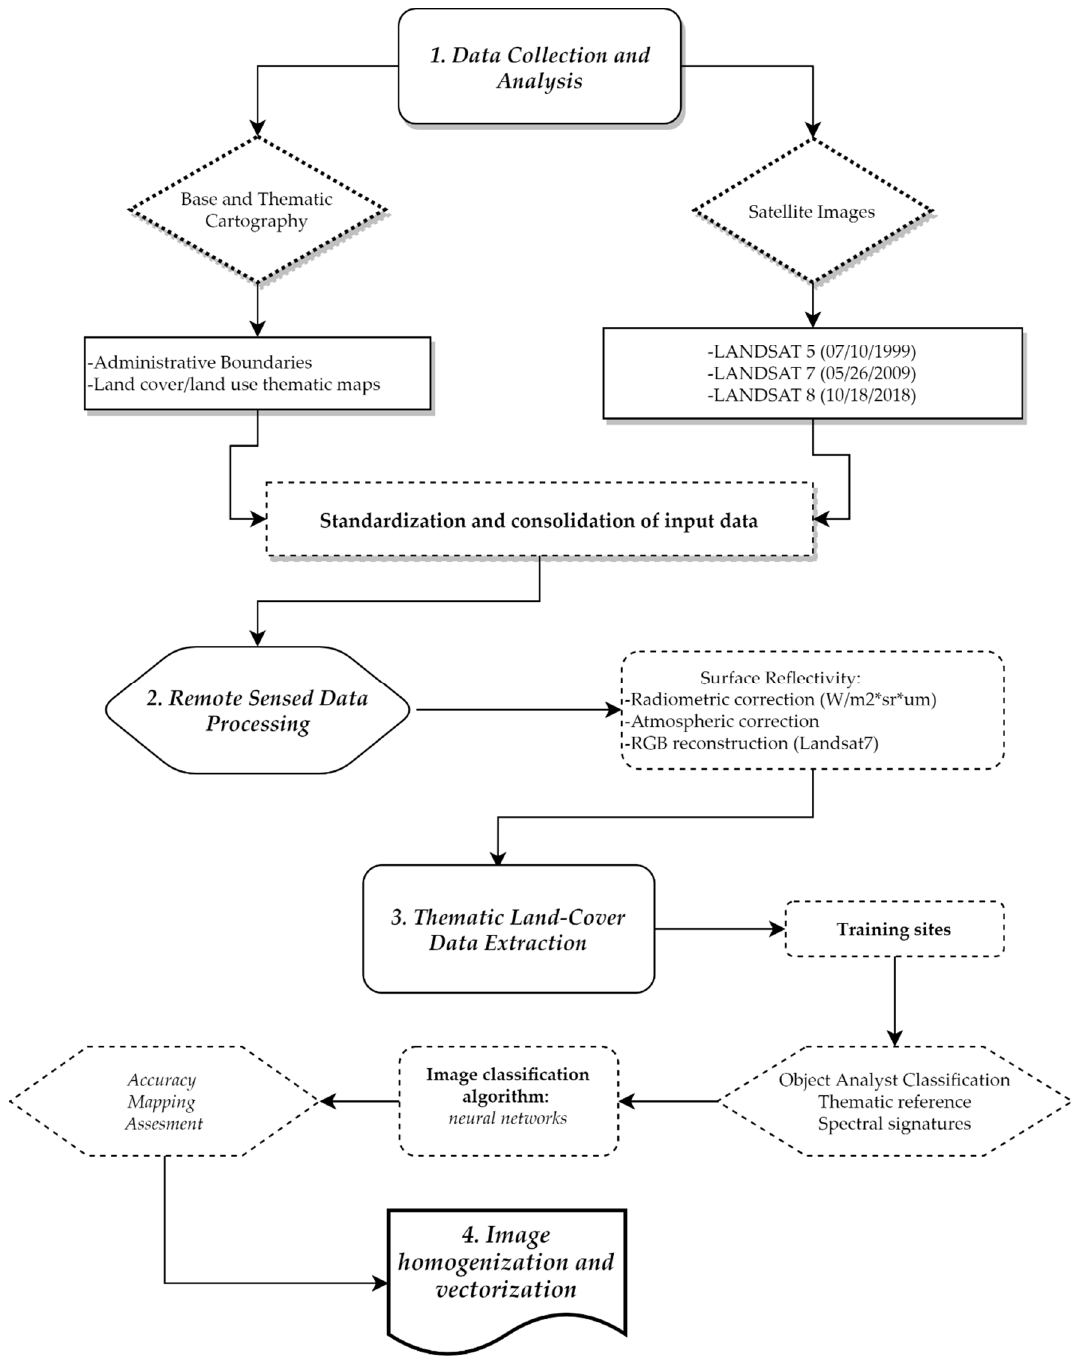
Figure 4. Workflow for the LULC methodology, in the period from